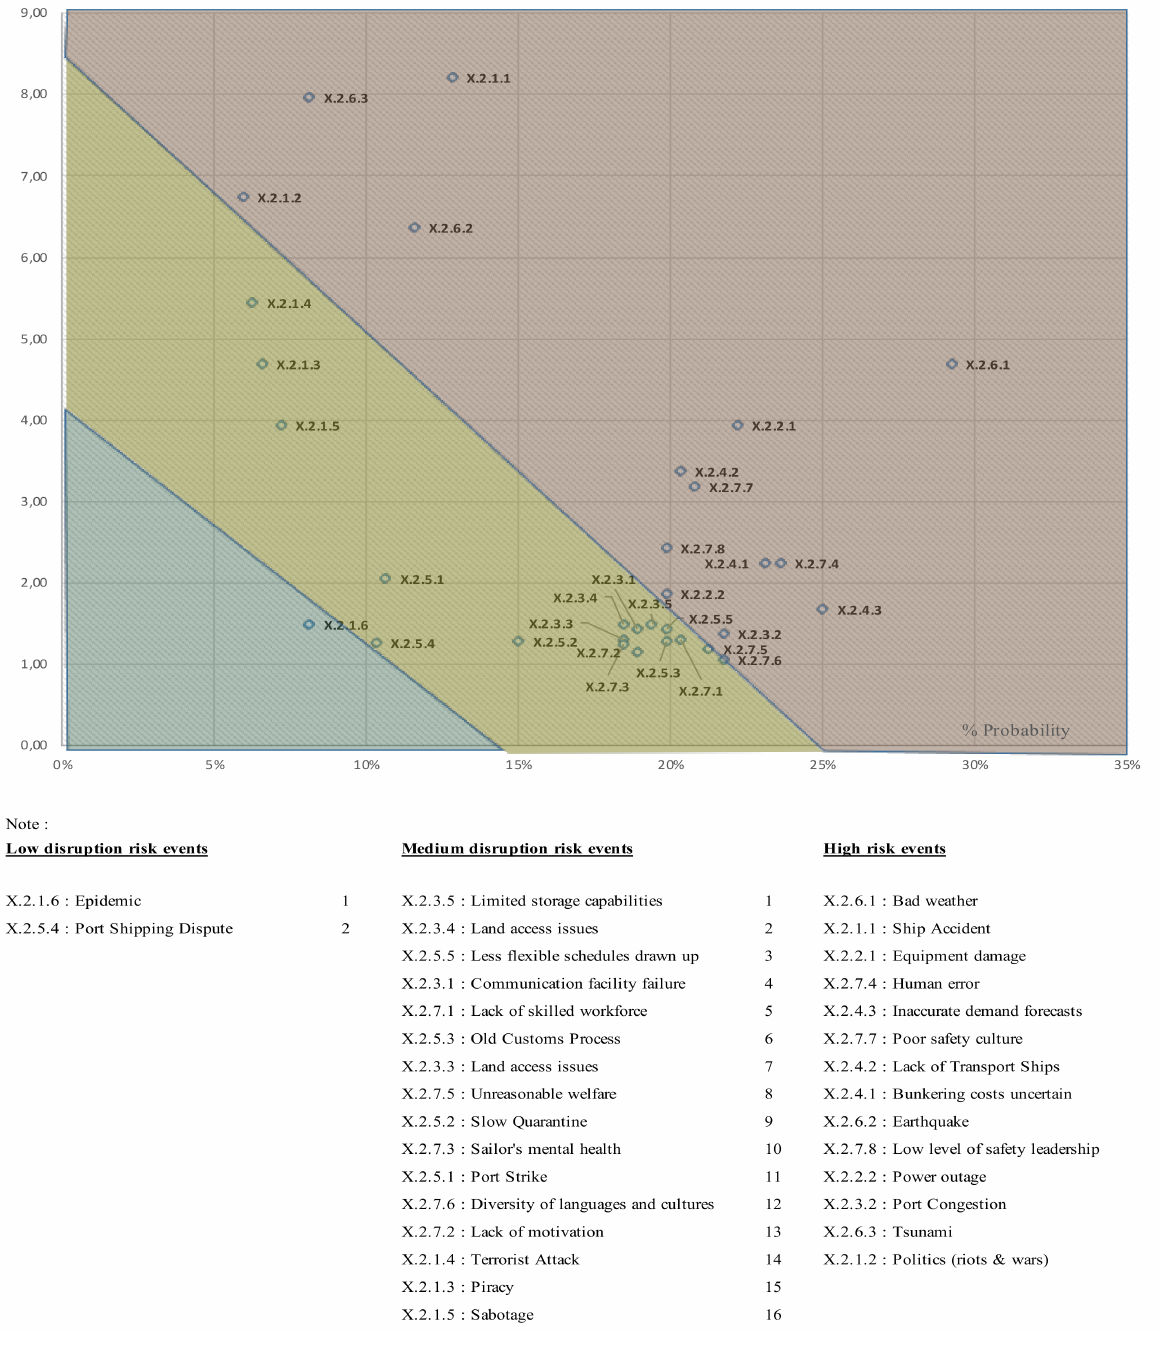
Figure 7. Classification and Rating of Risk Indicators by Disturbance Level. From the risk index assessment, the risk categories are divided into low risk, medium risk, and high risk, as shown in Figure 7. The low-risk category contains 2 risk indicators, the medium-risk category contains 16, and the high-risk category contains 14. Each of these risk indicators will be examined further to determine the extent to which the relationship between them affects SS-LNG supply chain